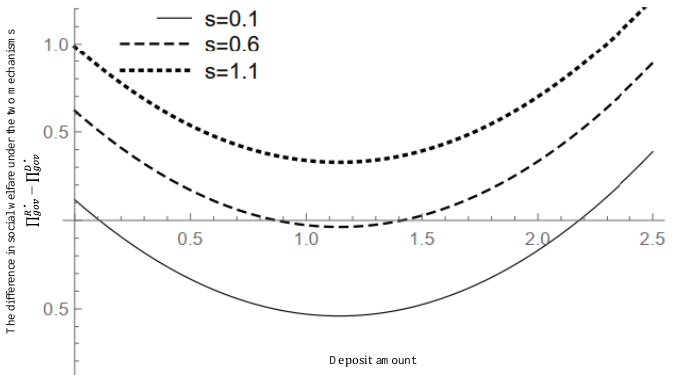
Figure 6. Impact of reward/penalty coefficient and deposit amount on the social welfare ( 𝑘 = 0.5 ).